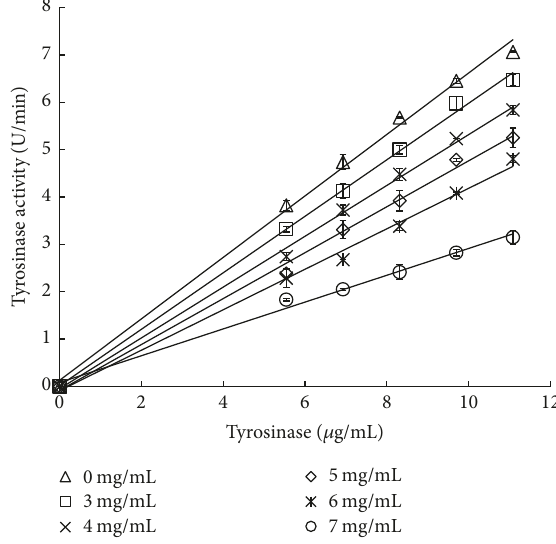
Figure 4: Effect of proso millet extract concentration (0 ∼ 7mg/mL) on the relationship between tyrosinase concentration and